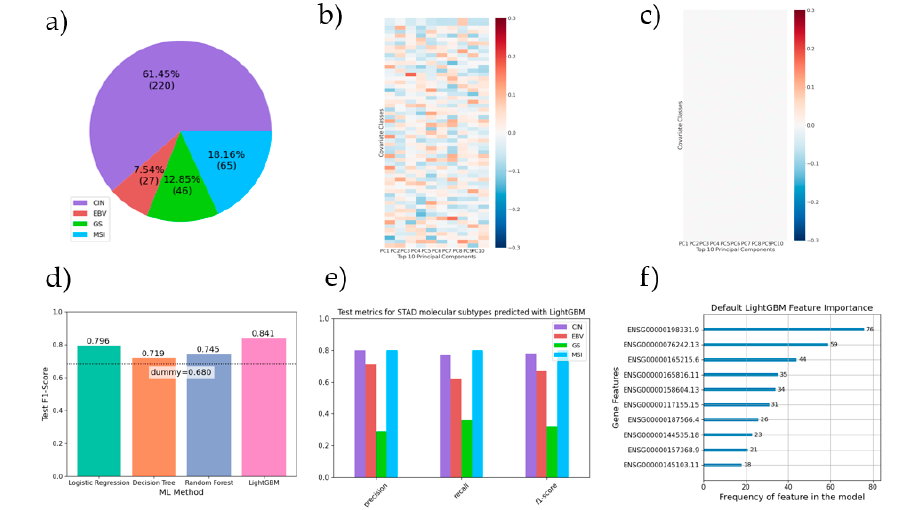
Figure 2. ( a ) Distribution of STAD molecular subtypes in the data (N = 358). ( b , c ) Correlation heatmap between clinical covariates and the top 10 gene expression principal components. ( b ) Before covariate decorrelation. ( c ) After covariate decorrelation. ( d ) Distribution of test f1-scores across methods, as compared to the dummy estimator’s (which always predict most frequent class) score. ( e ) Test metrics obtained using LightGBM with default settings, stratified by class. ( f ) The top 10 gene features by their importance for the LightGBM default